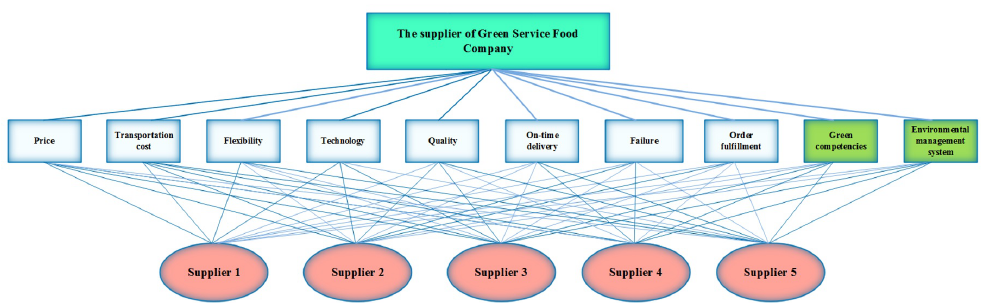
Figure 2. AHP hierarchy for supplier selection in Green Service Food